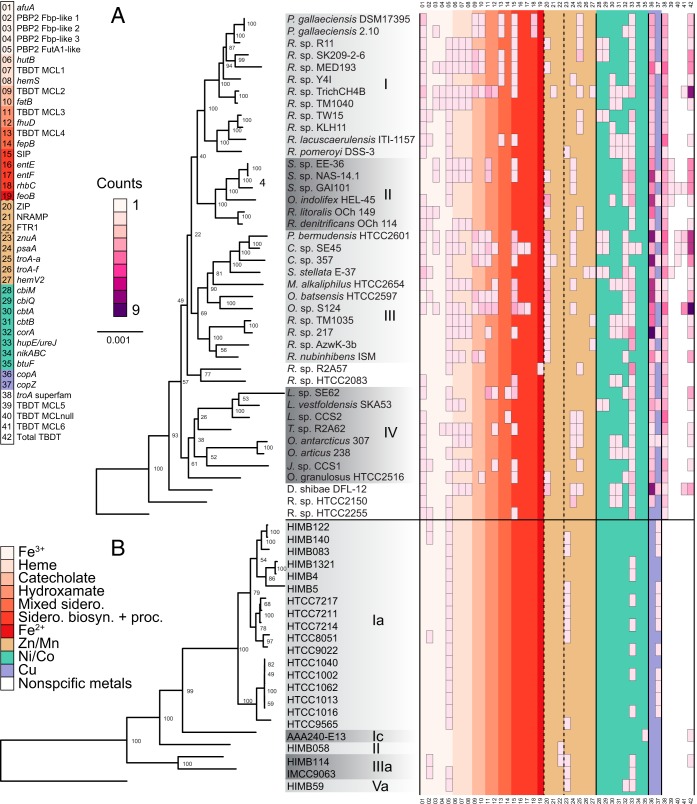
Maximum-likelihood phylogenies of 42 Roseobacter genomes (A) and 22 SAR11 genomes (B). Node values indicate bootstrap values from 1,000 resamplings. The scale bar represents 0.001 substitution per sequence position in both trees. Shaded boxes beneath Roseobacter names in panel A indicate the four major clades as presented in reference 43, while those in panel B denote five major clades in the SAR11 group. The central grid represents the absolute abundance of each respective metal uptake system per genome, the values of which are represented by color as shown in the scale labeled “Counts.” Classes of metal uptake systems are partitioned by color, as shown in the lower left corner. Specific metal uptake genes are referenced by number and color on the upper left, where numbers correspond to rows in the central grid. NRAMP, FTR1, and ZIP transporters interact with Fe, Zn, and Mn and are indicated with dashed lines.